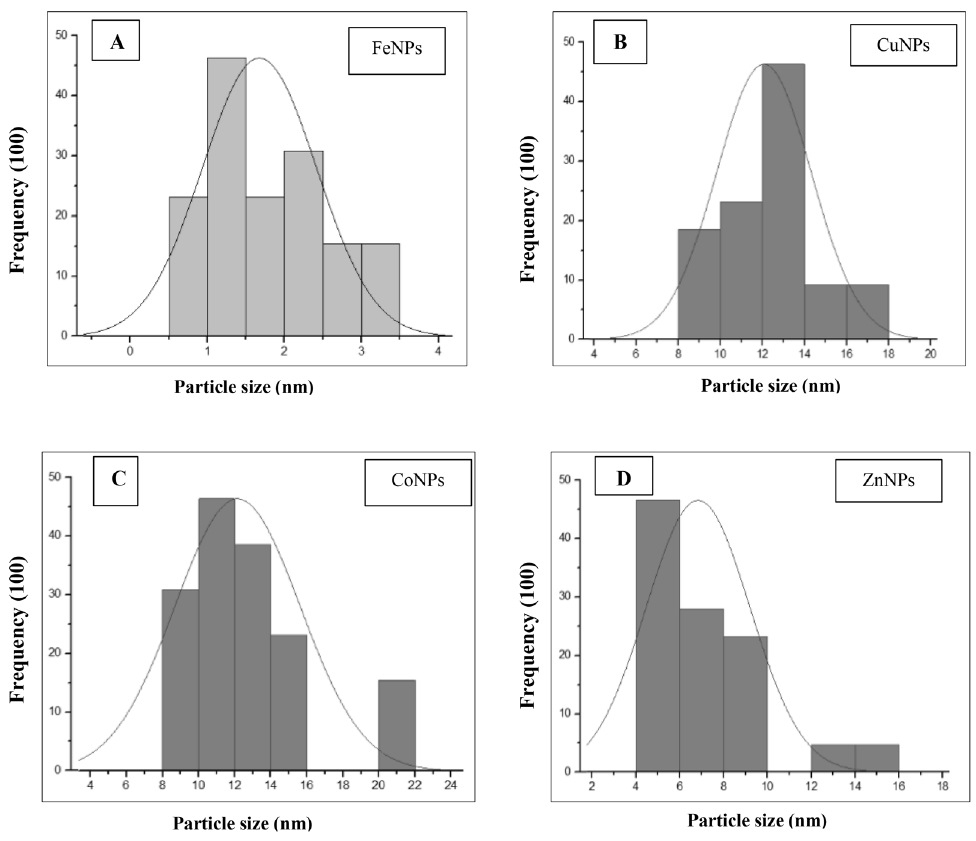
Figure 9. Particle size distribution histogram of FeNPs ( A ), CuNPs ( B ), CoNPs ( C ) and ZnNPs ( D ).